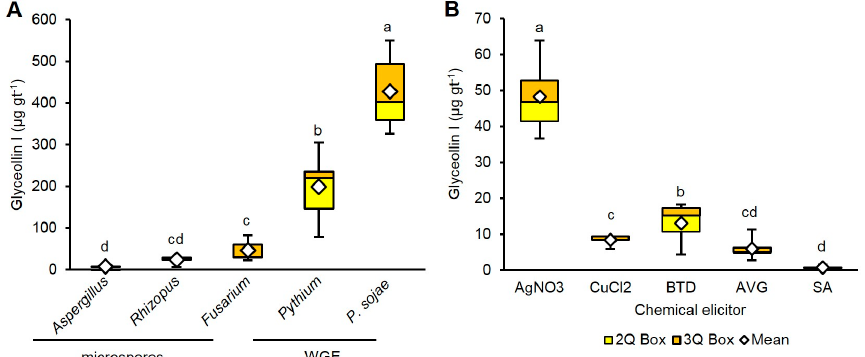
Figure 3. ( A ) Amounts of glyceollin I from soybean seeds treated with biotic elicitors for 24 h. Two-way ANOVA, Tukey post hoc test ( p < 0.001); ( B ) Treatment of seeds with chemical elicitors (AgNO 3 ), copper chloride (CuCl 2 ), benzothiadiazole (BTD), aminoethoxyvinyl glycine (AVG), and salicylic acid (SA)